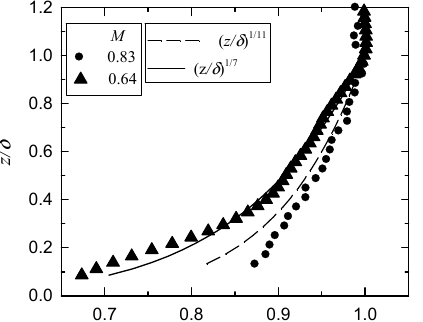
Figure 3. Normalized velocity profiles for M = 0.64 and 0.83. Ten pressure taps (2.5-mm in diameter) were machined perpendicular to the surface of each instrumentation plate along the centerline. Five pressure taps were upstream (spacing = 6 mm) and five were downstream (spacing = 12 mm) of the VGs, respectively, as shown in Figure 2. Three types of VGs (CRV, CoV, and Ramp) were used [16]. Sketches of l , of 1 δ and a value for α of 15 ◦ . The width of the CRV and CoV types, w v , was 0.2 δ and,